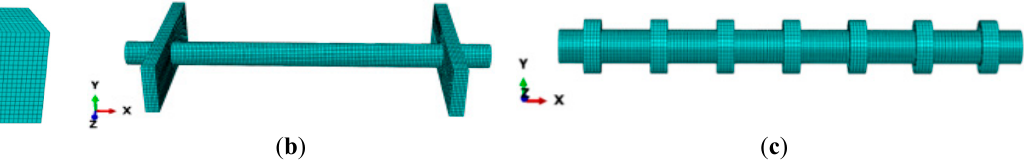
Figure 1. Component modeling and meshing, ( a ) asphalt concrete, ( b ) I-shaped sensor, ( c ) corrugated-shape sensor.